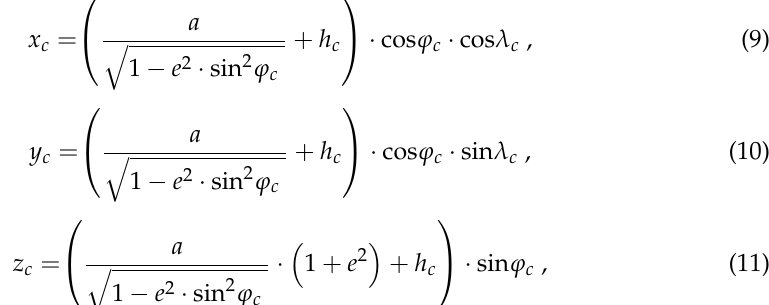
Figure 4. Graphical interpretation of base rotation the method of binding T C with the UAV camera projection